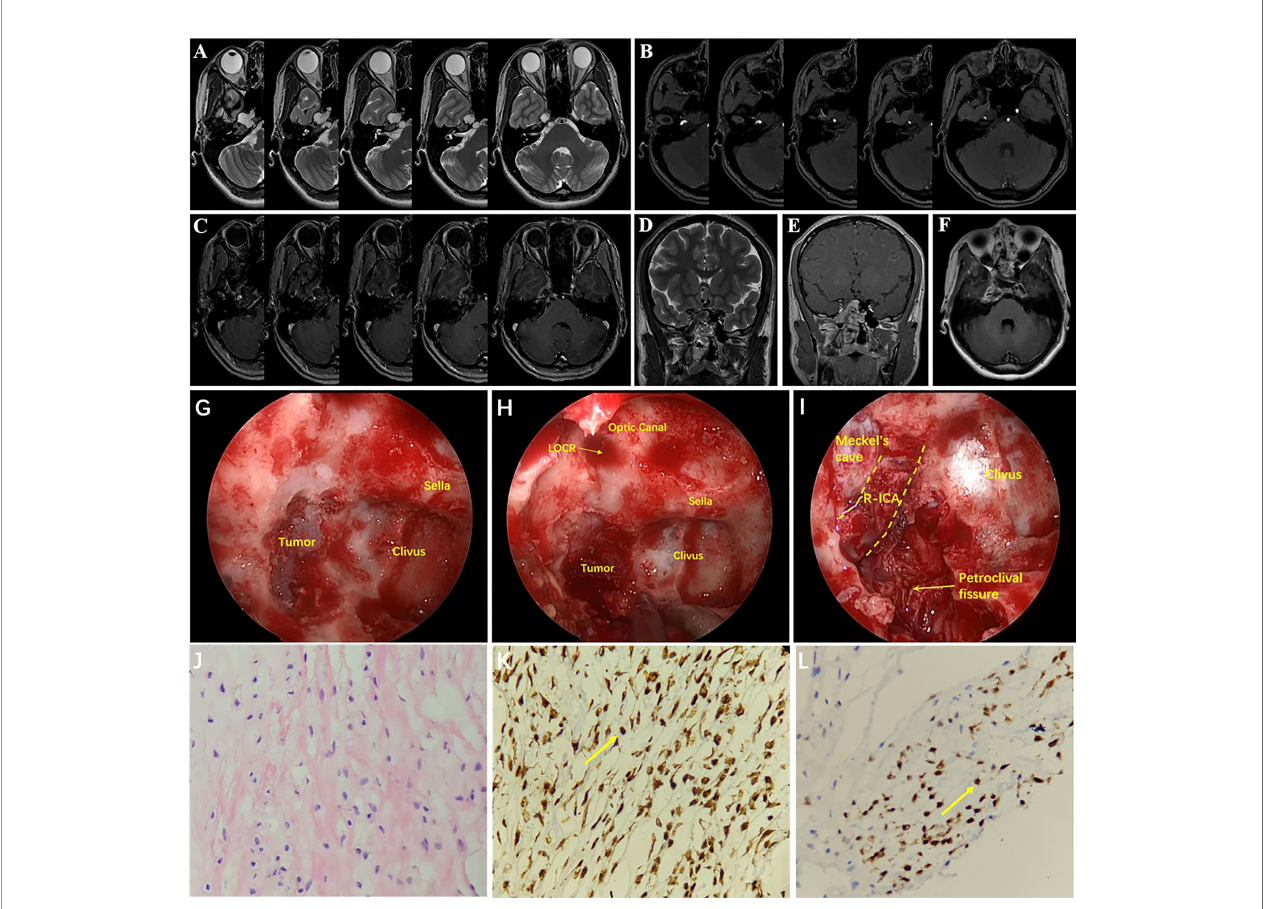
FIGURE 4 | MRI showed irregular long T2 signal and punctate low T2 signal at the base of the right-middle cranial fossa and posterior cranial fossa (A) . The tumor communicated intracranially and extracranially. MRA showed compression and displacement of the right ICA by the tumor (B) . The tumor showed uneven enhancement (C) . Coronal T2 image (D) and coronal T1 (E) and axial T1 (F) contrast-enhanced images on postoperative MRI showed that the tumor was resected completely. Drilling the petroclival bone and exposing the tumor (G) . Resection of petroclival tumor (H) . After resection of tumor, right internal carotid artery and petroclival fi ssure were exposed (I) . Histopathology results at 200× magni fi cation revealed chondrocytes of varying sizes and cytoplasmic intermediate vacuole formation (J) . Immunohistochemical staining at 400× magni fi cation showed vimentin (+, K ) and S-100 (+, L ). LOCR, lateral opticocarotid recess; R-ICA, right internal carotid